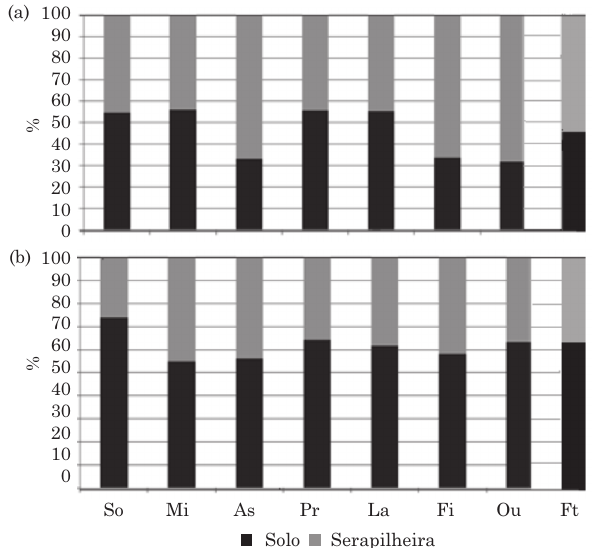
Figura 2. Distribuição vertical da fauna do solo total (FT) e dos grupos funcionais nos compartimentos solo e serapilheira para as duas estações estudadas, verão (a) e inverno (b). So: Insetos sociais; Mi: Micrófagos; As: Saprófagos; Pr: Predadores; La: Larvas; Fi: Fitófagos; e Ou: